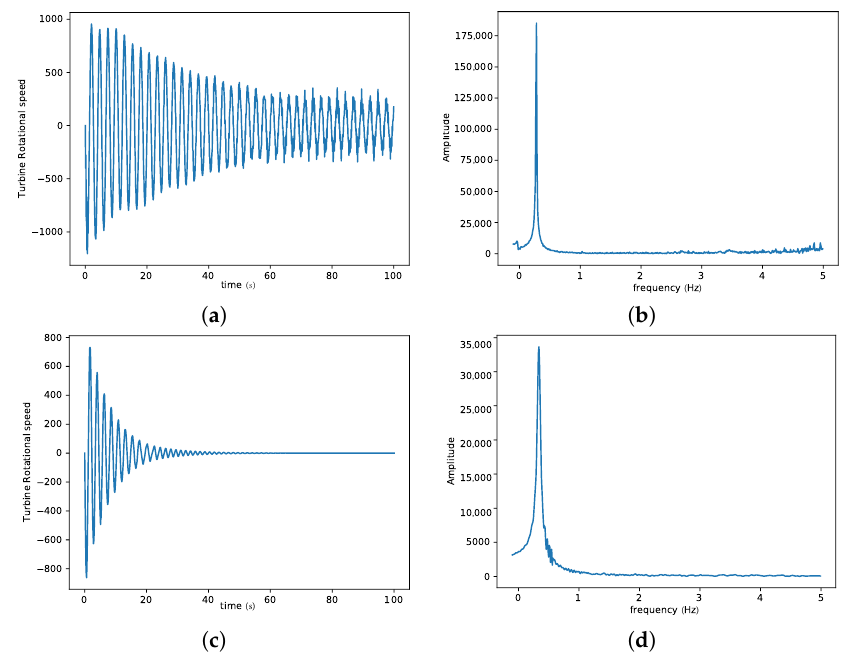
Figure 5. A plot of wind turbine rotational speed ( ˙ θ 1 ) vs. time (t) to study the effect of higher damping and torsional stiffness. ( a , b ) are the time series and the corresponding FFT frequency spectrum plots for low damping and torsional stiffness at K l = 1.0, K h = 0.01, K 2 = K 3 = 0.005, C l = 0.05, C h = 0.009, C 2 = C 3 = 0.01, C m = 0.001, D t = 0.01, D g = 0.009 and β = π /6. In ( c , d ), the damping and torsional terms have been increased by a factor of 10.